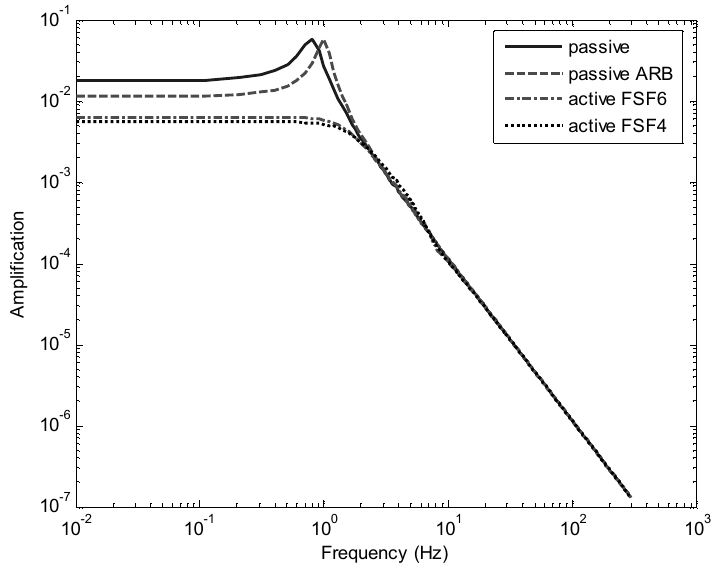
Fig. 13. Roll angle for lateral acceleration